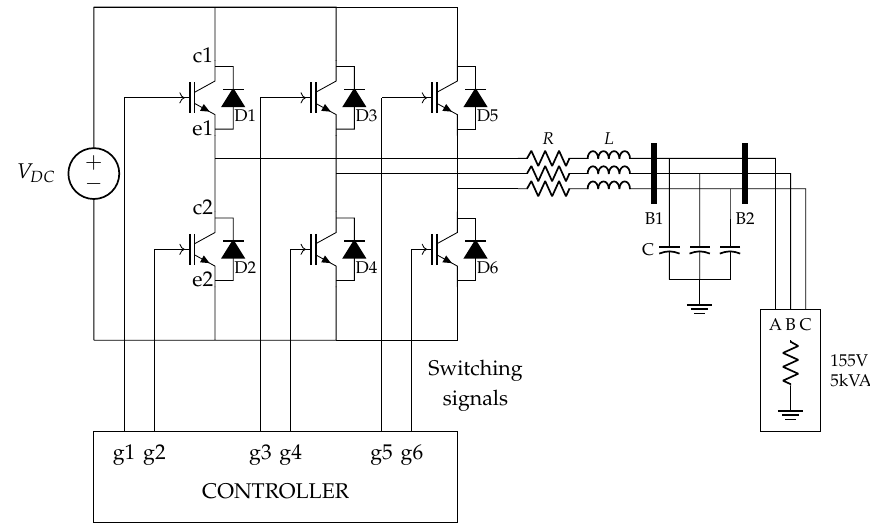
Figure 8. Modelling of the VSC in